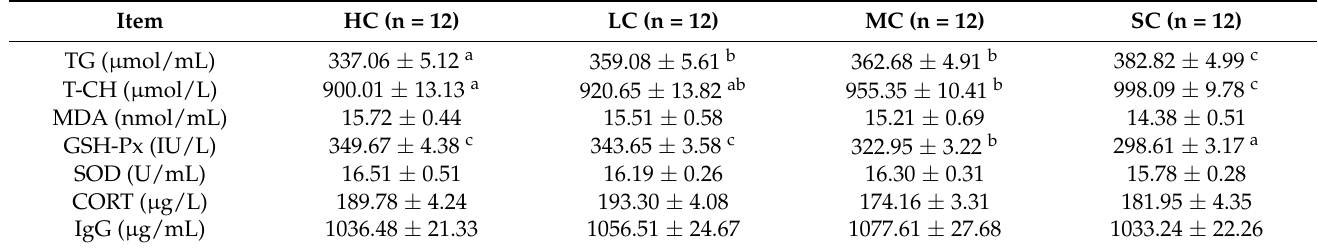
Table 3. Effects of cage size on the serum biochemical indices of laying hens.